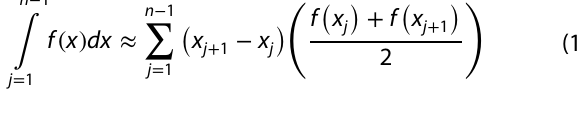
imposed onto a sample of Ni-MOF-74@ 4